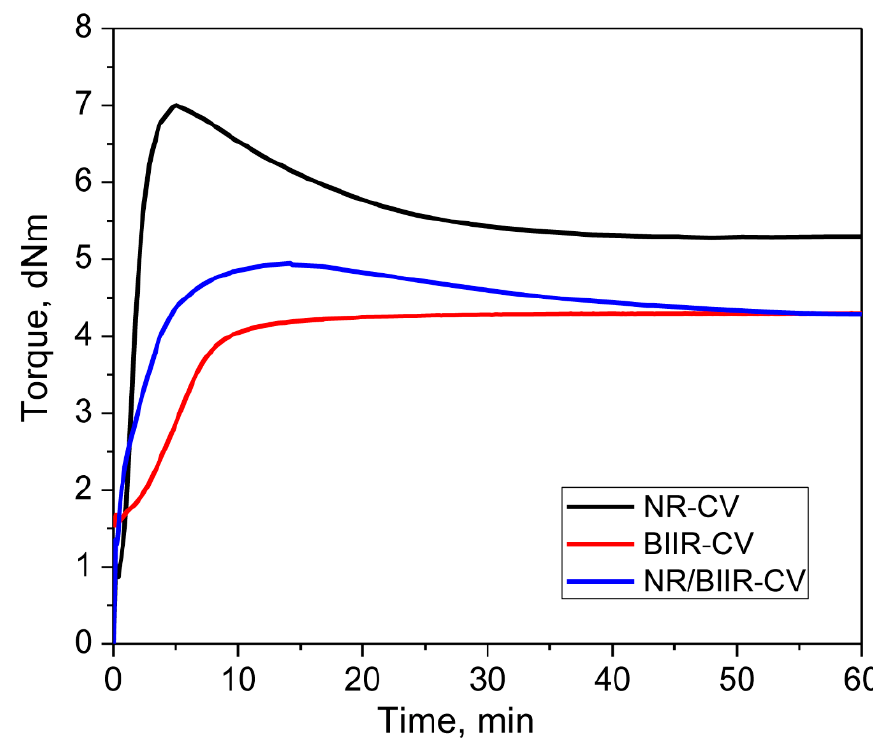
Figure 2. Curing curves of NR-CV, BIIR-CV and NR/BIIR-CV. Table 2. Cure characteristics of the mixes at various